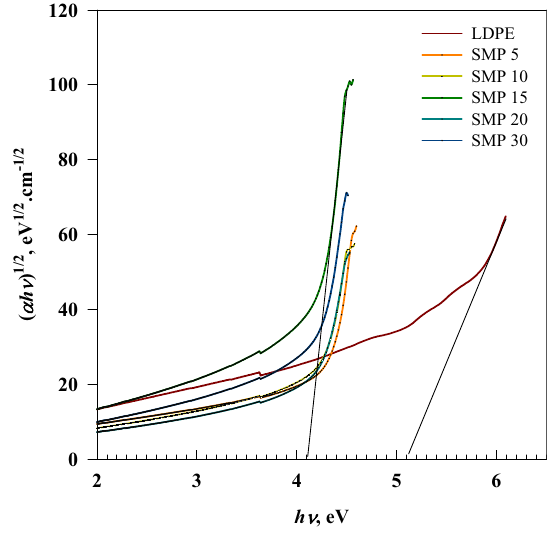
Figure 5: The plots of ( α hv ) 1/2 vs ( hv ) for all fi lms.